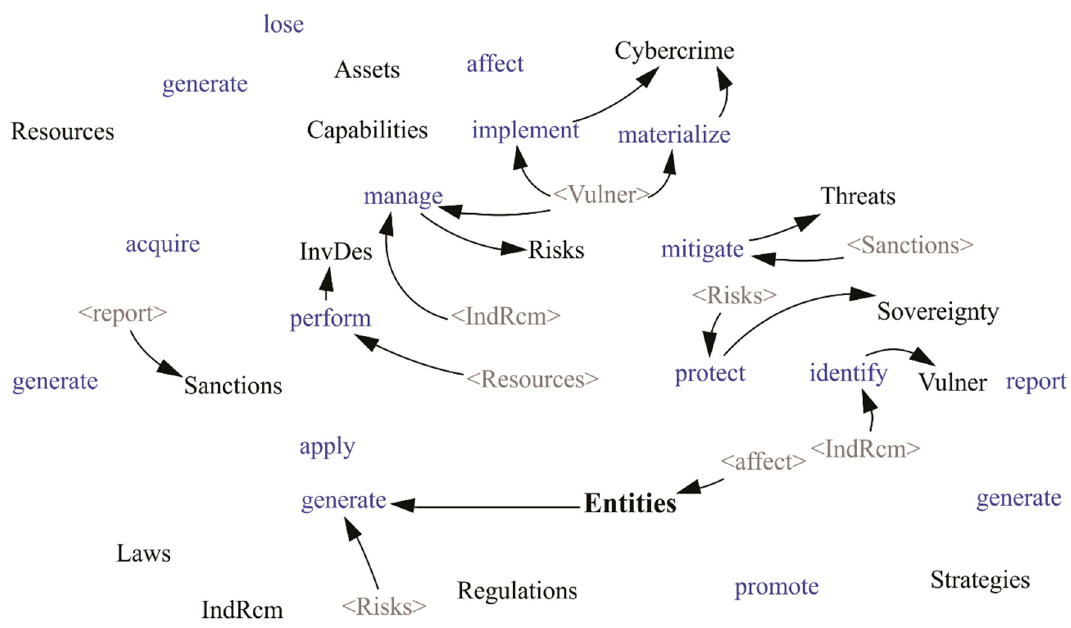
Figure 10. Use of clones to facilitate reading.